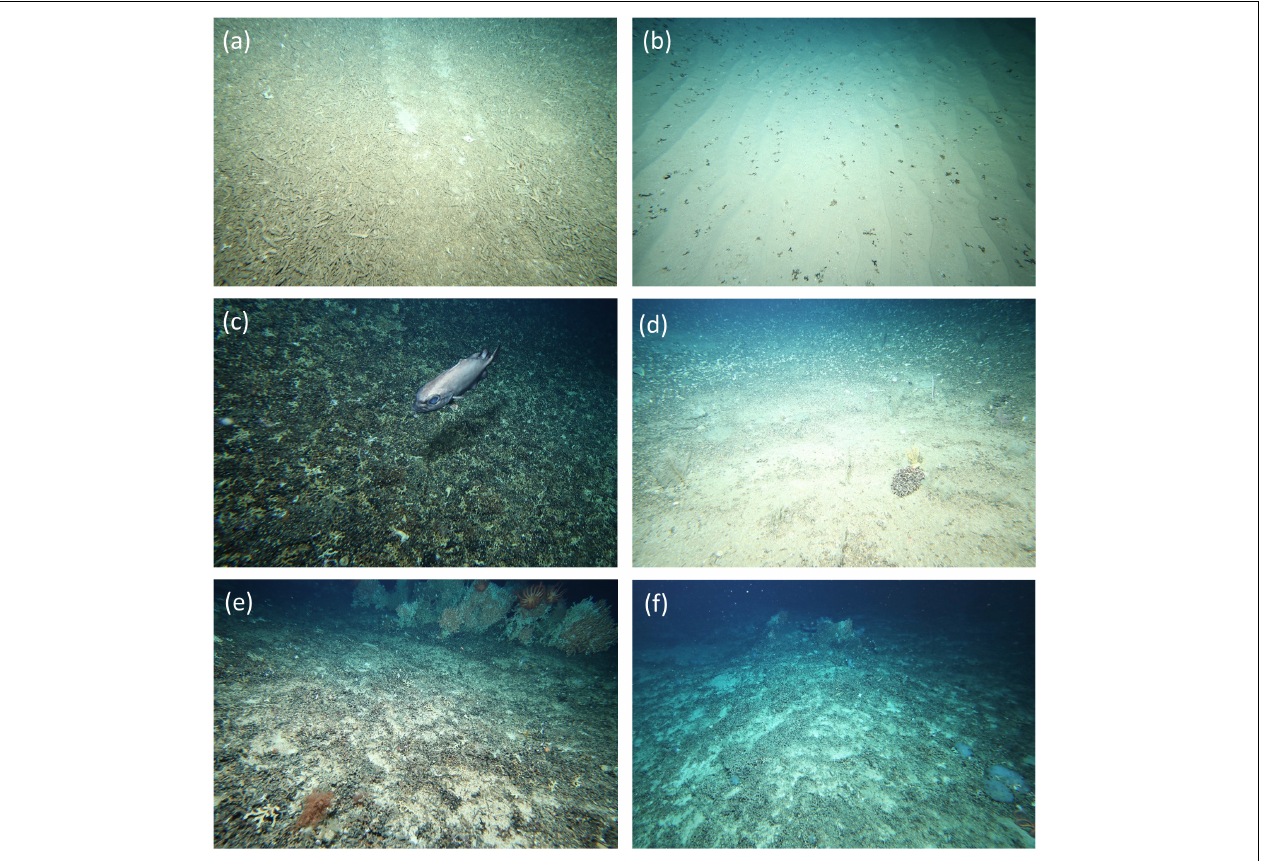
FIGURE 3 | Examples of impact indictors: (a) “dense rubble” with “gear mark” – St Helens (685 m); (b) “fragments” – Main Matt (1,003 m); (c) “sheared” – Atoll (1,072 m); (d) “clumps” – Pedra (1,079 m); (e) “trawl scar” – Hill U (1,172 m); (f) “undetermined” – Z5 (1,347